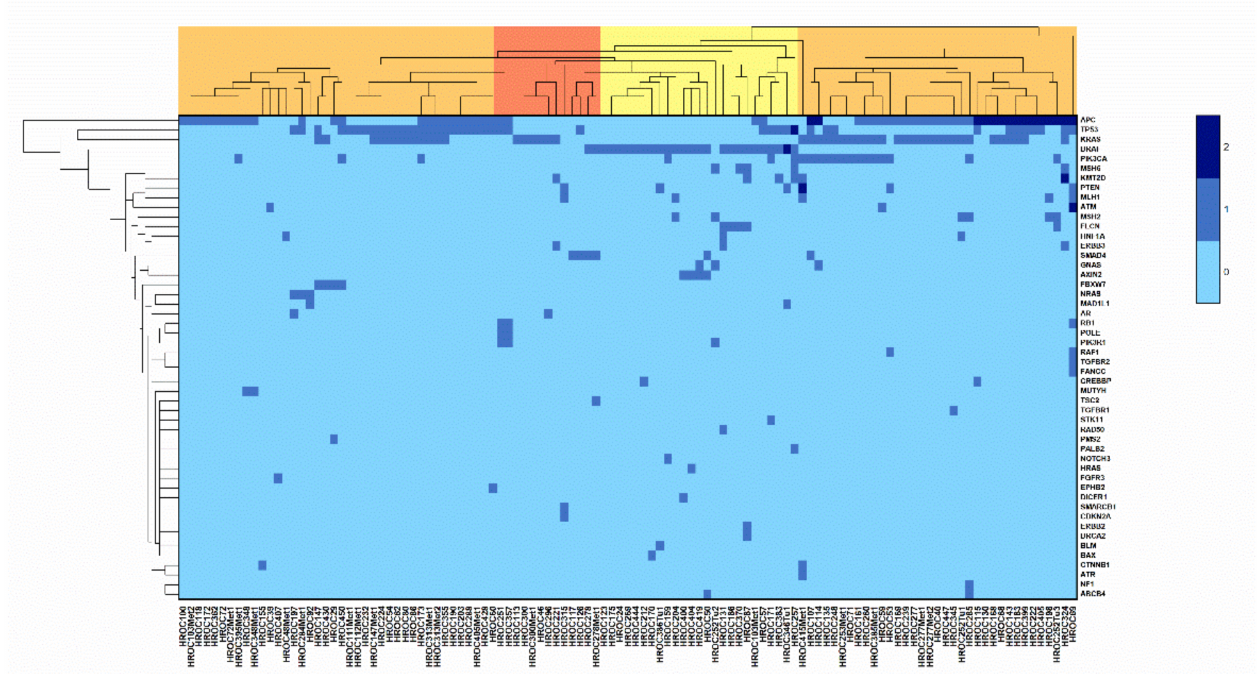
Figure 2. Unsupervised cluster analysis for all investigated tumors concerning the pathogenic or likely pathogenic mutations, with the following parameters: cluster method = Furthest Neighbor; distance type =